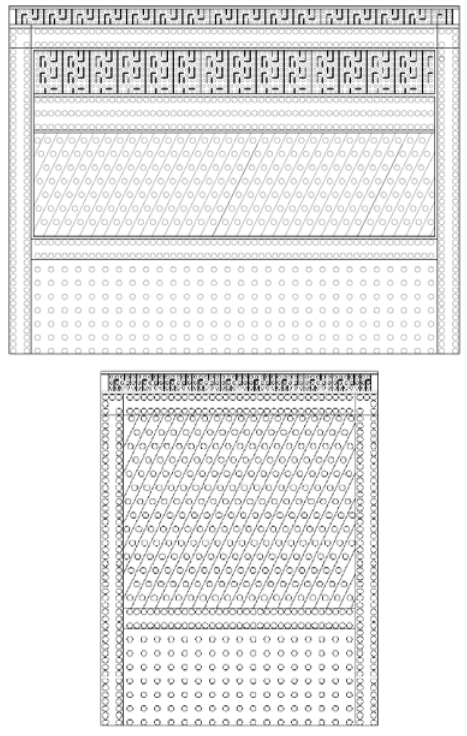
Figure 12. Vector drawing of the reconstructed front (top) and side (bottom) of the